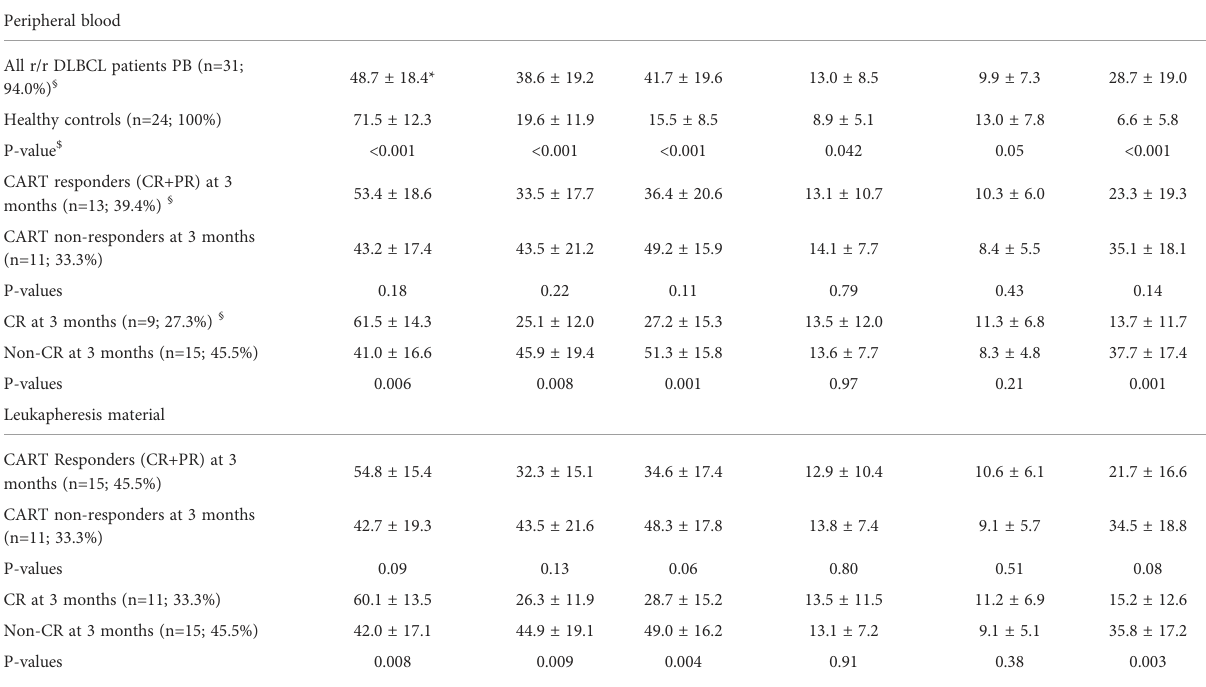
TABLE 3 PB and leukapheresis material of r/r DLBCL patients scheduled for CART cell therapy contain signi fi cantly more CD3 + T cells with a differentiated CD27 - CD28 - phenotype when compared to healthy control